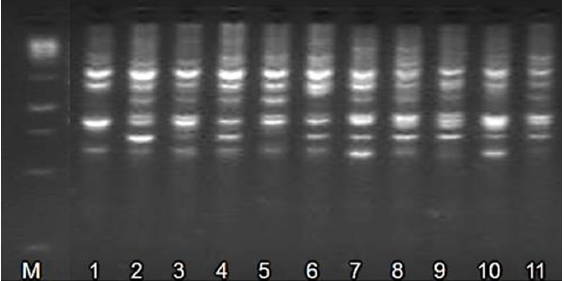
Figure 1 - Electrophoretic profile of primer ISSR-30 for the 11 pineapple genotypes in 2.5% agarose gel: 1- ‘BRS Imperial’; 2- ‘Pérola’; 3- ‘Smooth Cayene’; 4- PE x SC-73; 5- ‘BRS Vitória’; 6- ‘BRS Ajubá’; 7- ‘BRS Anauê’; 8- FIB-POT; 9- ‘BRS Boyrá’; 10- FIB-gOr and 11- ‘Curauá’. M = ladder 1 Kb (Qiagen TM